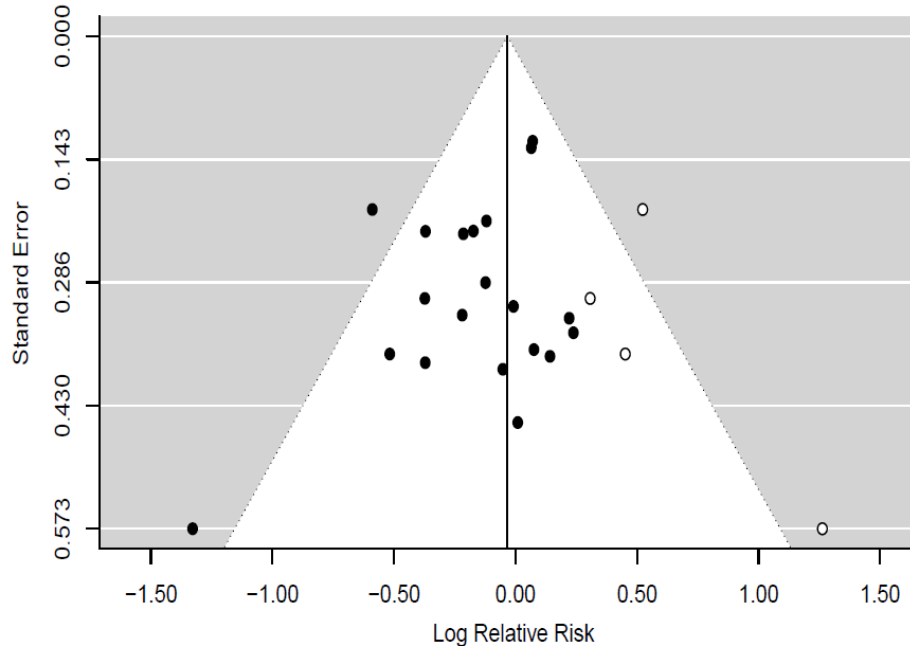
Figure 9. Funnel plot based on the trim and fill method for fixed effects